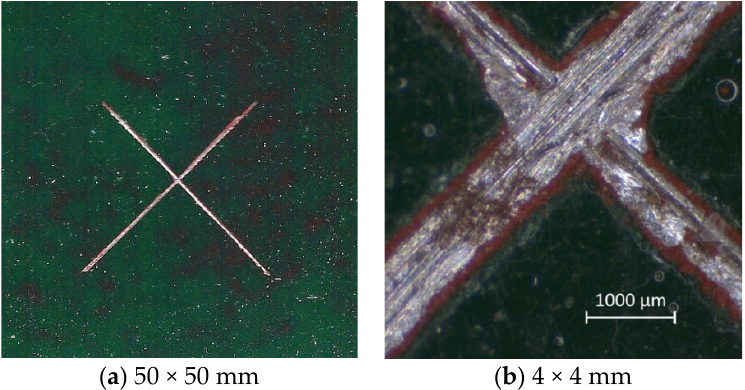
Figure 6. Deterioration of the surface layer and corrosion of steel under microbial colonies after 8 weeks of exposition, ( a ) overview, ( b ) macroscopic image.